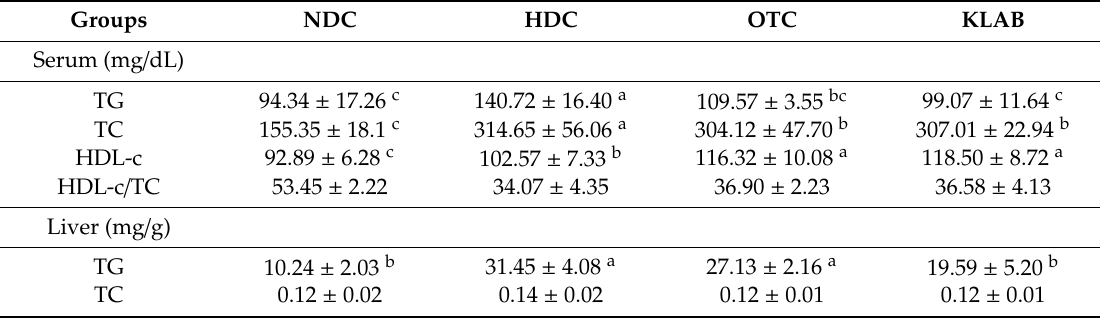
Table 2. The e ff ect of L. brevis OPK-3 on serum and hepatic lipid profiles in mice.